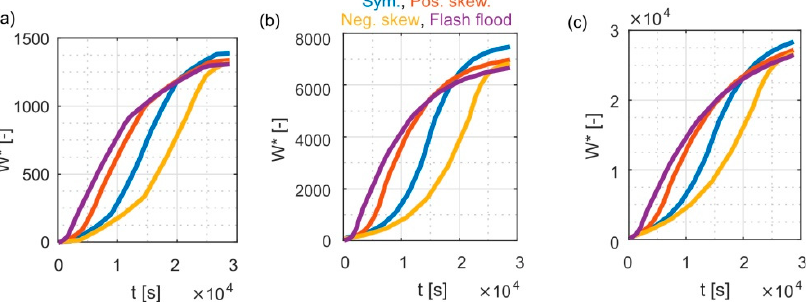
Figure 8. Dimensionless flow work (W*) of Series A experiments: ( a ) scenario 1 (clear water), ( b ) scenario 2 (transitional), and ( c ) scenario 3 (channel degradation).